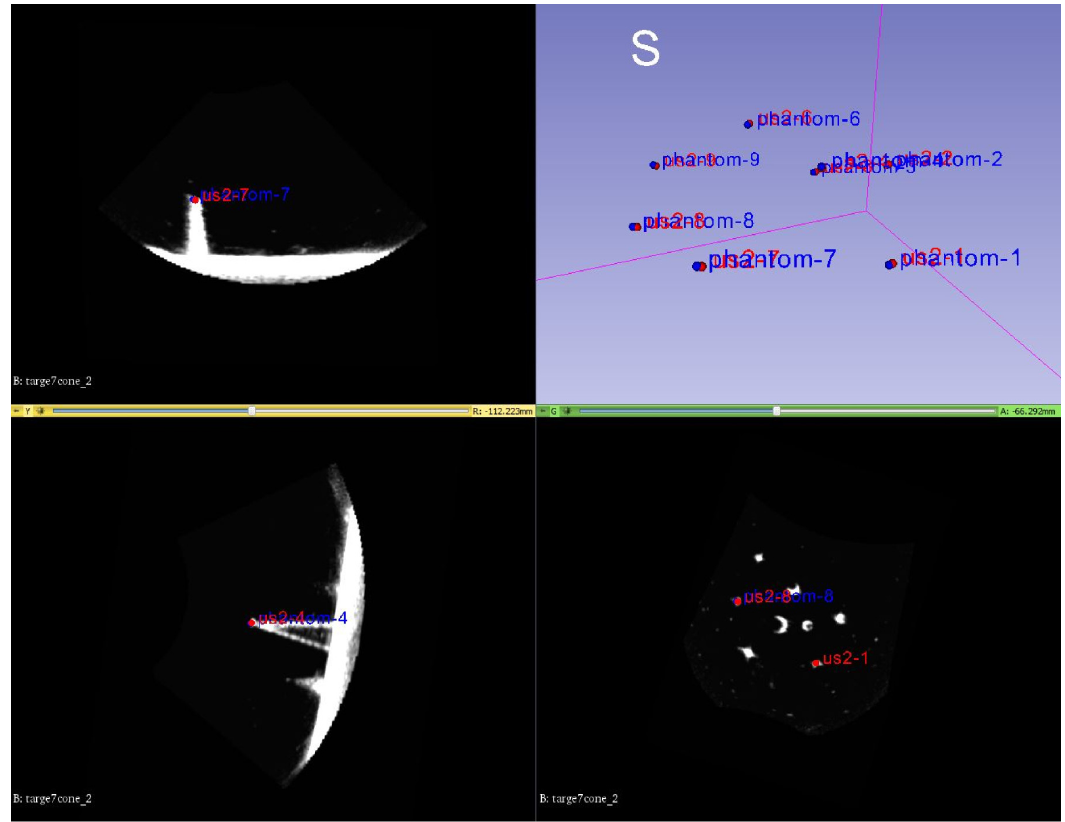
Fig 6. US target registration error on 3D Slicer: Points are collected on the image (red dots) and overlaid by applying the transform to the ground truth phantom coordinates (blue dots).